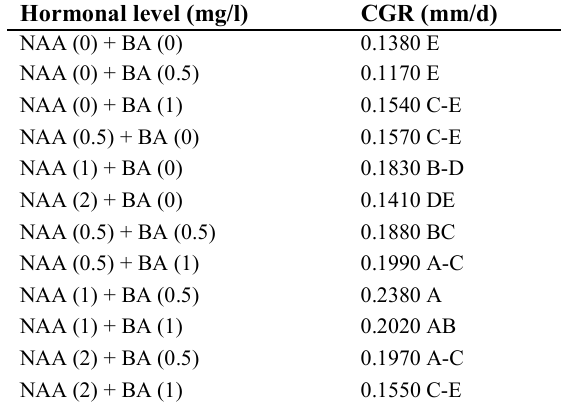
Table 2. Mean comparison for effect of hormonal level on callus growth rate in Cuminum cyminum L. GR: growth rate. Similar letters in each column didn’t have any significant statistical difference in 0.05